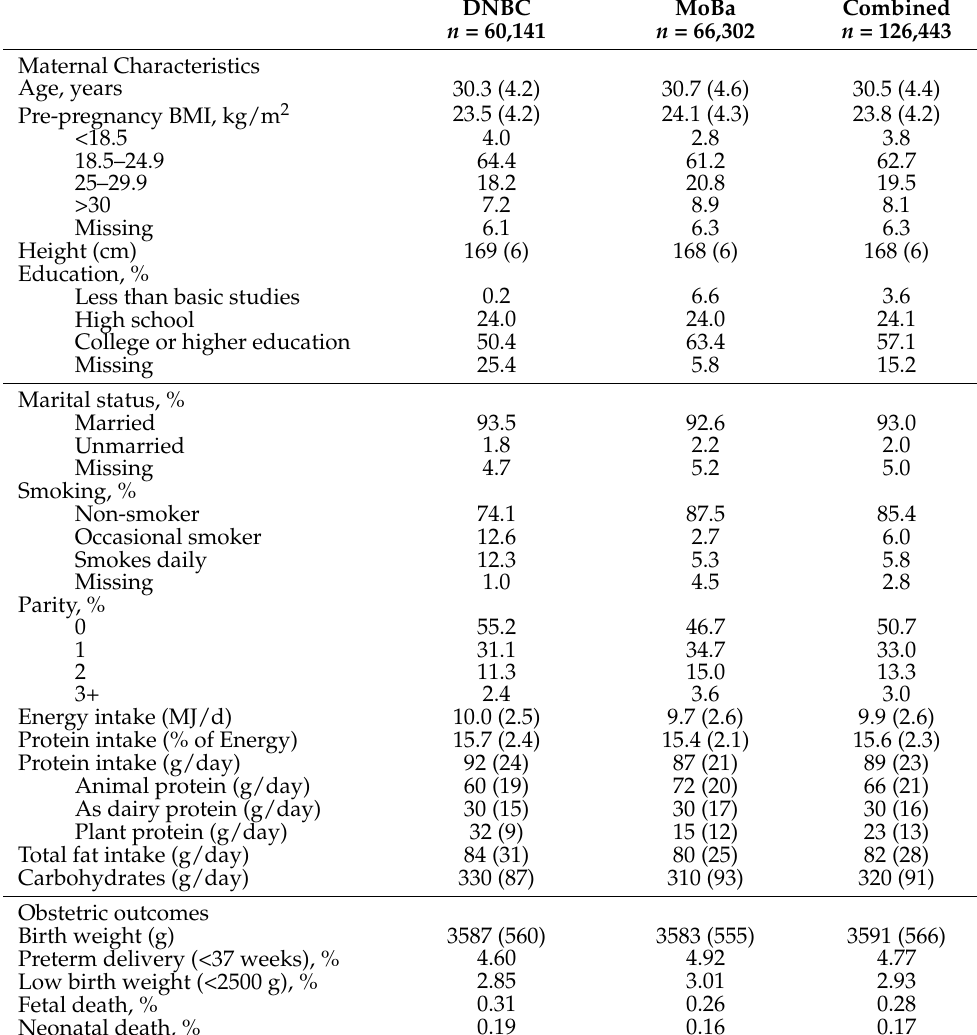
Table 1. Characteristics of participants in the Danish National Birth Cohort (DNBC, 1996–2002) and the Norwegian Mother, Father and Child Cohort study (MoBa, 2002–2008). DNBC n = 60,141